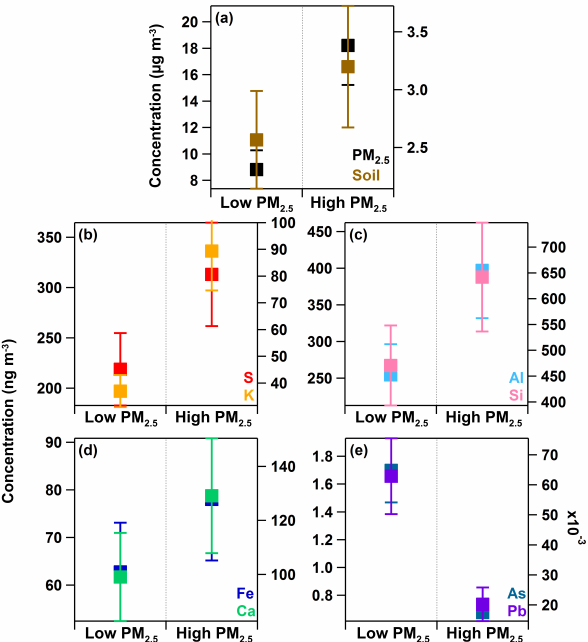
Figure 13. Averages of (a) PM 2 . 5 and soil concentrations and (b– e) select metal mass concentrations during non-event days (i.e., cleaner conditions) compared to averages from haze event days (i.e., influence from fires haze) for 26 August–2 September 2015. “Low” and “high” correspond to the PM 2 . 5 concentration values. Error bars represent the 90% confidence intervals. Concentration aver- ages were statistically significant based on t tests of two samples of unequal